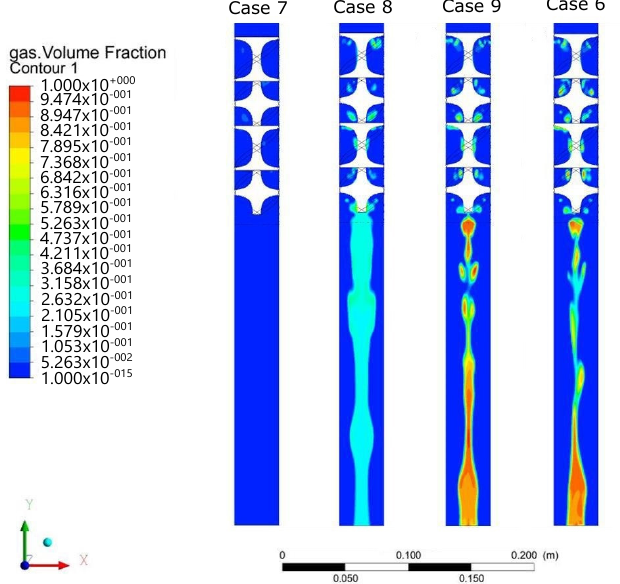
Figure 9. Gas distribution in multiphase